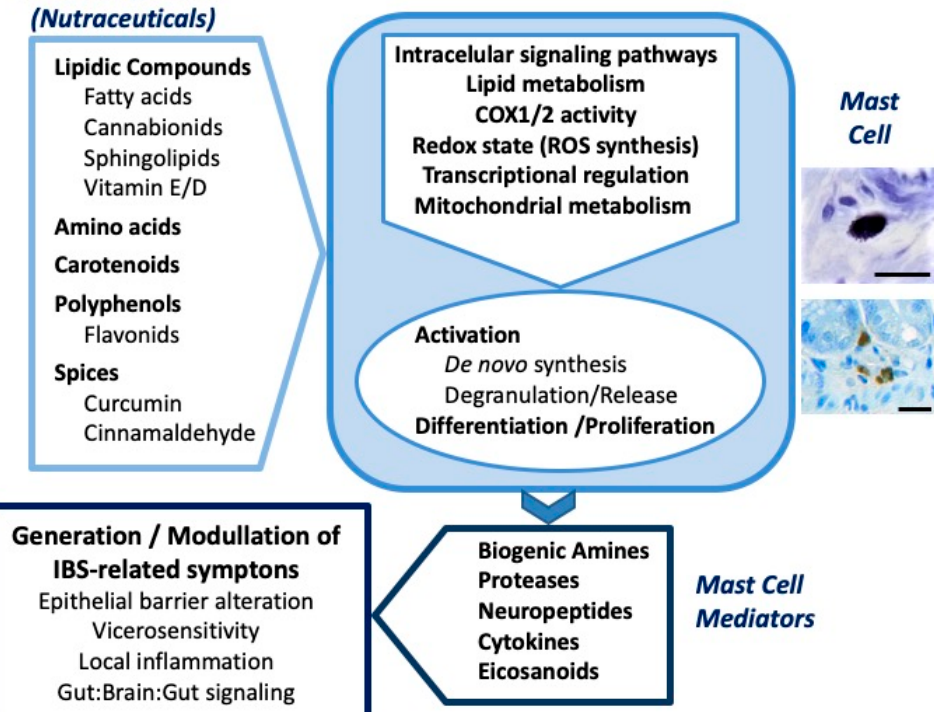
Figure 1. Schematic representation of the modulatory activity of food components on mast cells and their relationship with the generation and modulation of irritable bowel syndrome (IBS)-related symptoms. The figure integrates the main bioactive food components with potential nutraceutical use (as discussed in the text), the main mechanisms of action proposed on mast cells and some of the key symptoms related to IBS that can be modulated through the action of mast cell-derived mediators. See text for details. The photomicrographs (right) show mast cells in the rat intestine, identified with toluidine blue staining (upper photomicrograph) and rat mast cell protease 2 immunohistochemistry (lower photomicrograph). Scale bar: 20 μ m.